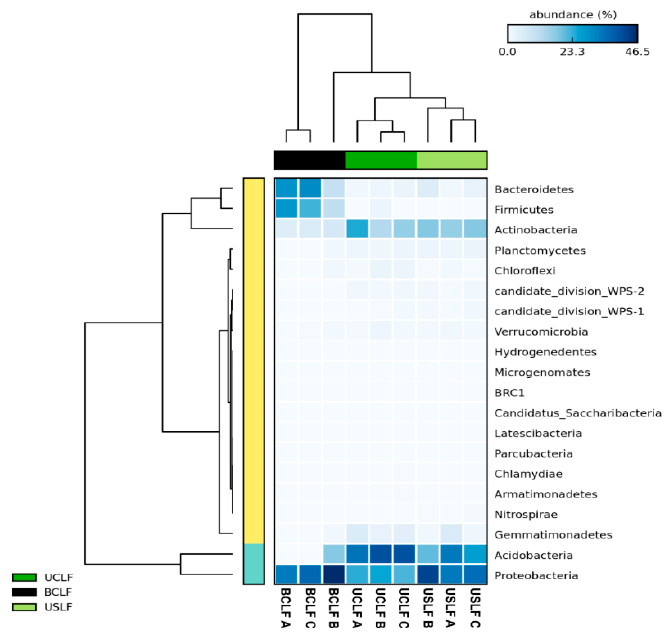
Figure 2. Heatmap plot of dominant phyla in undisturbed (USLF and UCLF) and burnt (BCLF) laurel forest soils.